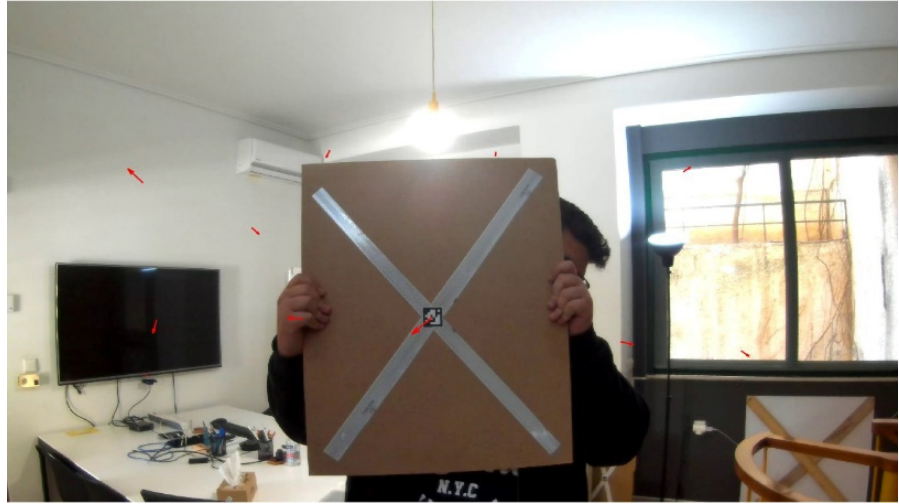
Figure 6. The reprojection errors are given as directional vectors for all measurements involved.